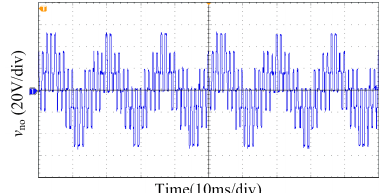
Figure 12. Experimental results under m = 0.9: ( a ) line to line voltage; ( b ) FFT of the line to line voltage; ( c ) three phase currents; ( d ) FFT of the phase current.